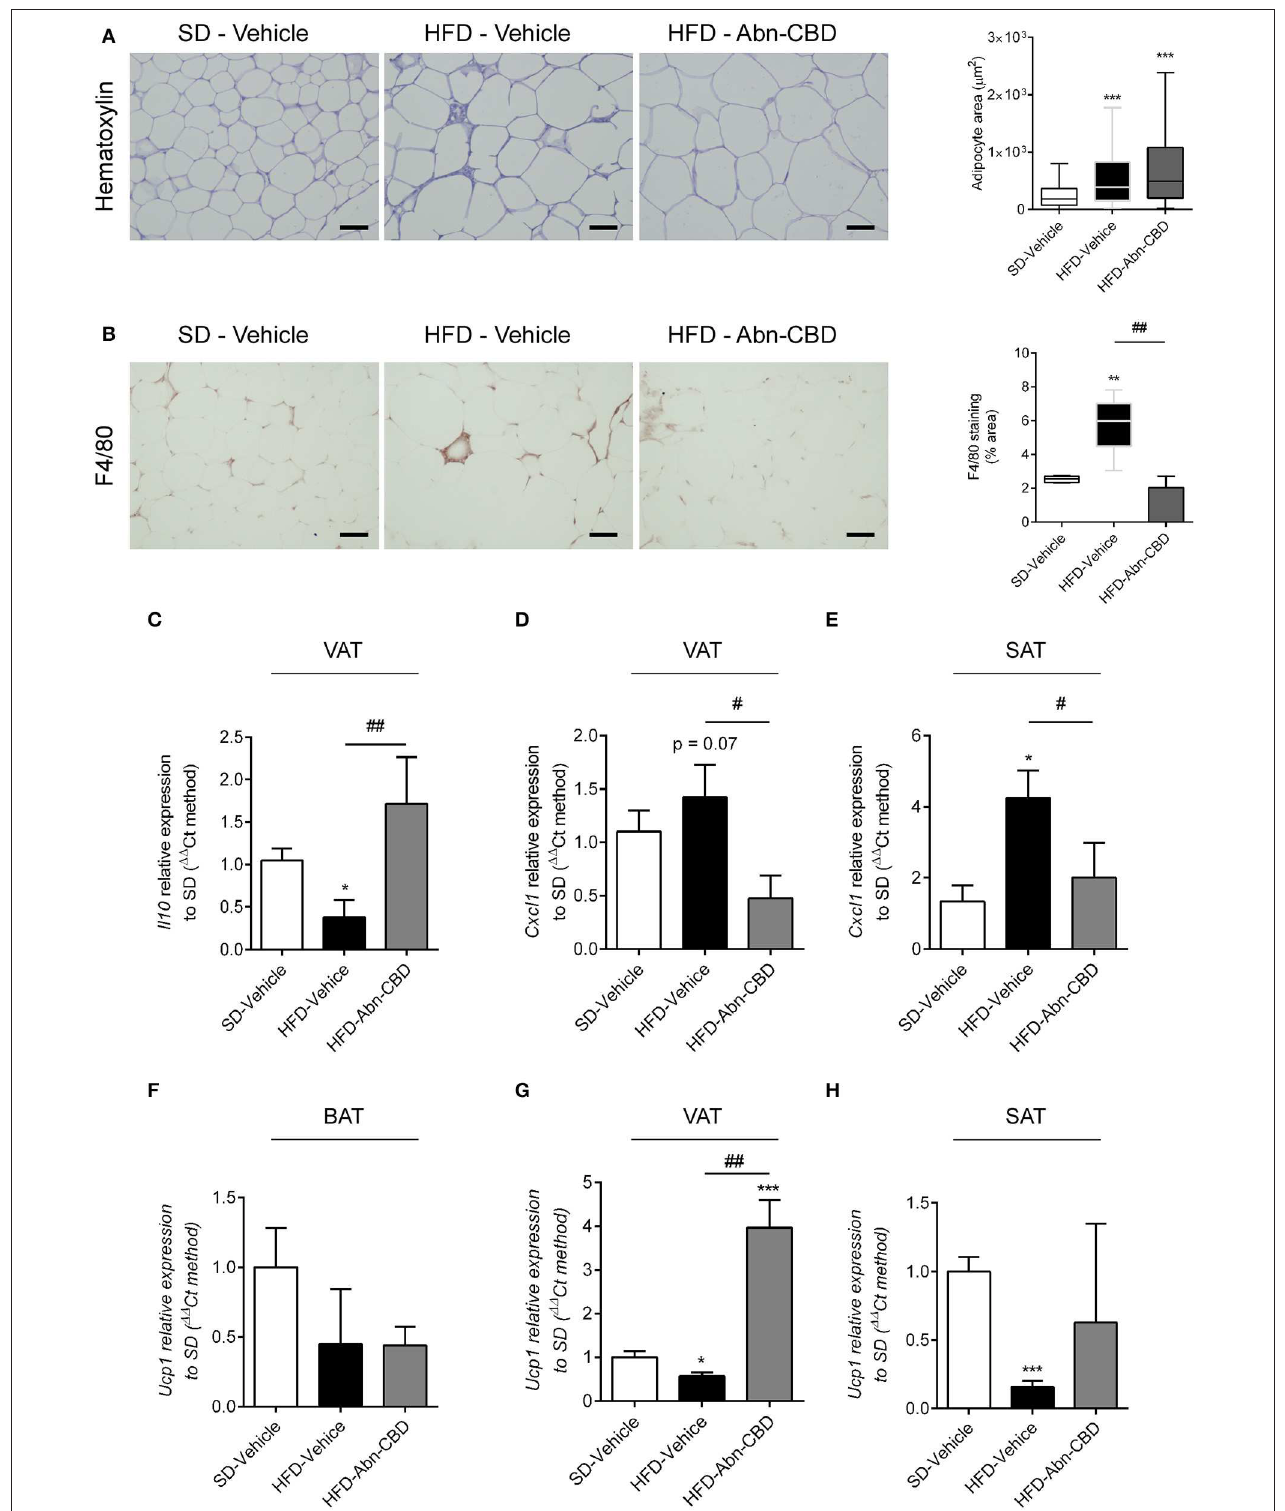
FIGURE 5 | Effect of Abn-CBD on inflammation in white adipose tissue. Representative photomicrographs and quantification of (A) adipocyte size and (B) crown-like structures in white adipose tissue. Relative expression of (C) Il10 and (D) Cxcl1 in visceral adipose tissue and of (E) Cxcl1 in subcutaneous adipose tissue. Relative expression of Ucp-1 in (F) brown adipose tissue, (G) visceral adipose tissue, and (H) subcutaneous adipose tissue. β -actin was used as reference gene. * p ≤ 0.05, ** p ≤ 0.01, and *** p ≤ 0.001 compared to SD-Vehicle; # p ≤ 0.05 and ## p ≤ 0.01 compared to HFD-Vehicle.